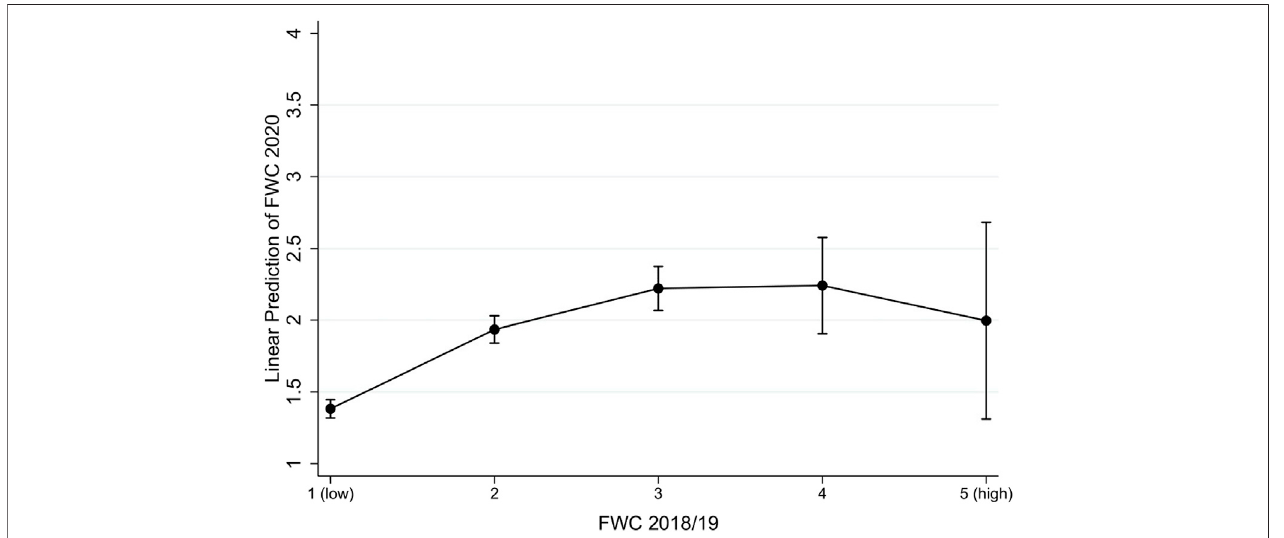
FIGURE 2 | Relationship Pre-COVID-19 Work-Family Con fl icts with Work-Family Con fl icts during the Pandemic. Note: Results based on Model M2, in Supplementary Appendix Table SA2 . 95% con fi dence bands for one-tailed tests.